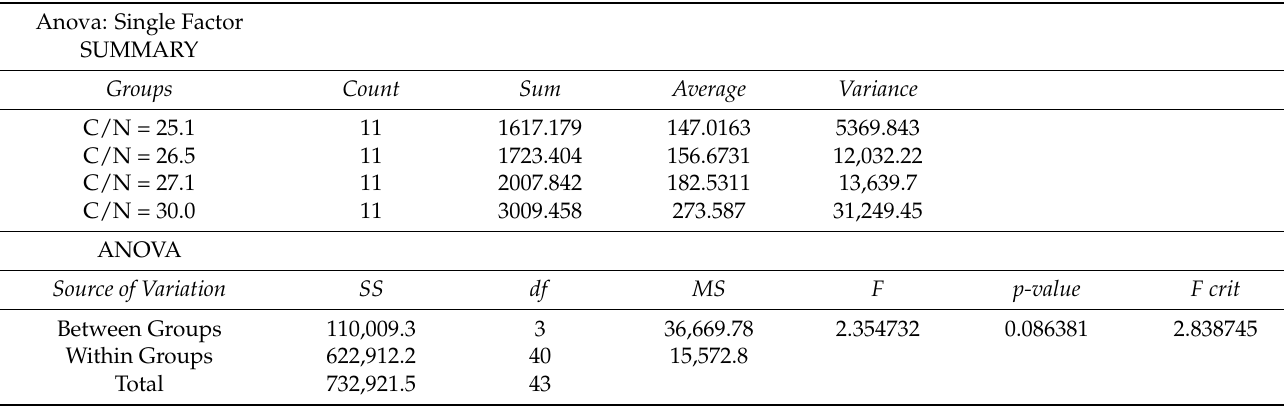
Table A7. One-way (ANOVA) test for methane yield every three days from the last four reactors. Anova: Single Factor